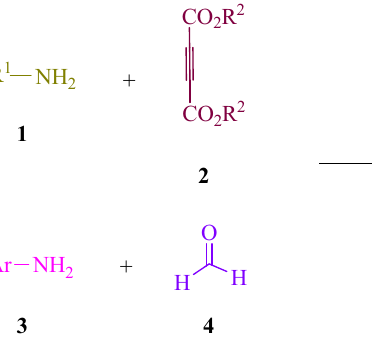
Figure 4. An approach to creating polyfunctionalized dihydro-2-oxypyrroles.